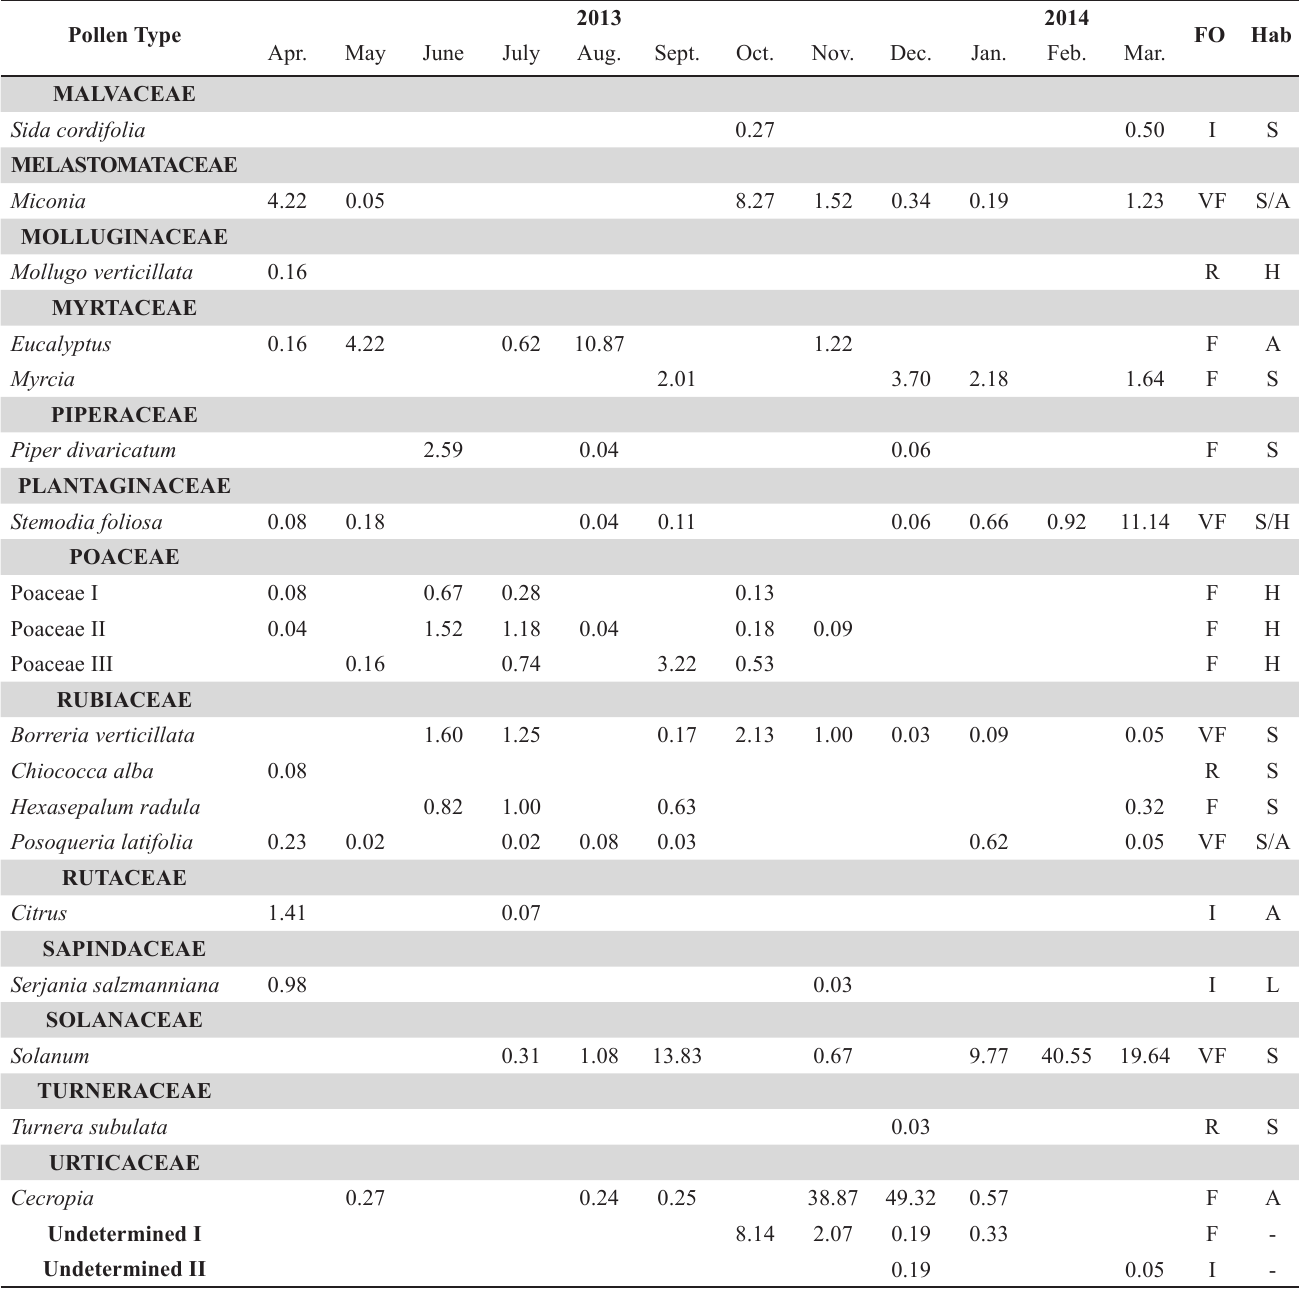
Table 1. Relative frequency (%) and classes of frequency of occurrence (FO) of pollen types occurring in pollen samples stored by Tetrago- nisca angustula (Latreille, 1811) in an Atlantic Forest area on the northern coast of Bahia. FO: Very Frequent (VF: > 50%), Frequent (F: 20% - 50%), Infrequent (I: 10% - < 20%) and Rare (R: < 10%). Habit (Hab) of plant species related to pollen types – A = Arboreal; S = Shrubby; H = Herbaceous; L = Liana.